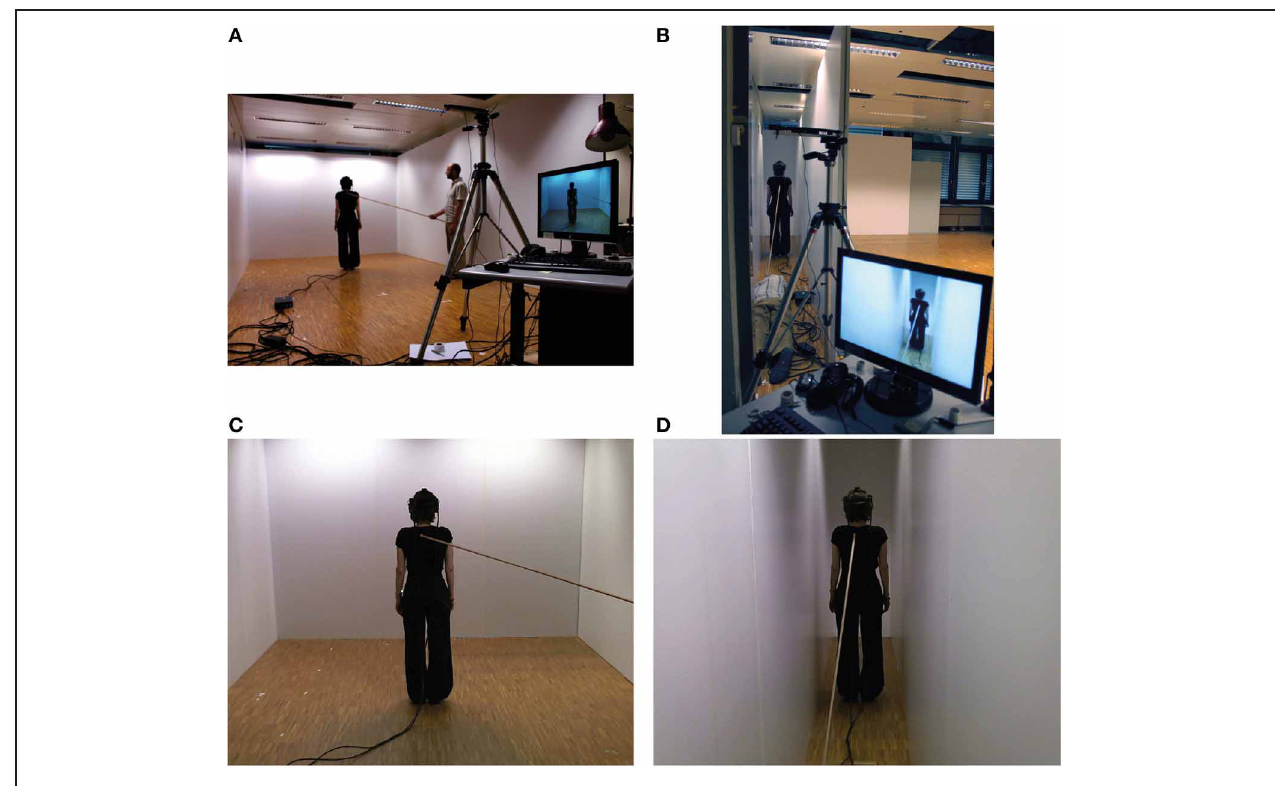
FIGURE 1 | The architectonic setup and the participant’s view. The setup with the movable walls and backstroking for the large room (A) and the narrow room (B) . The participant’s impression of space viewed through the